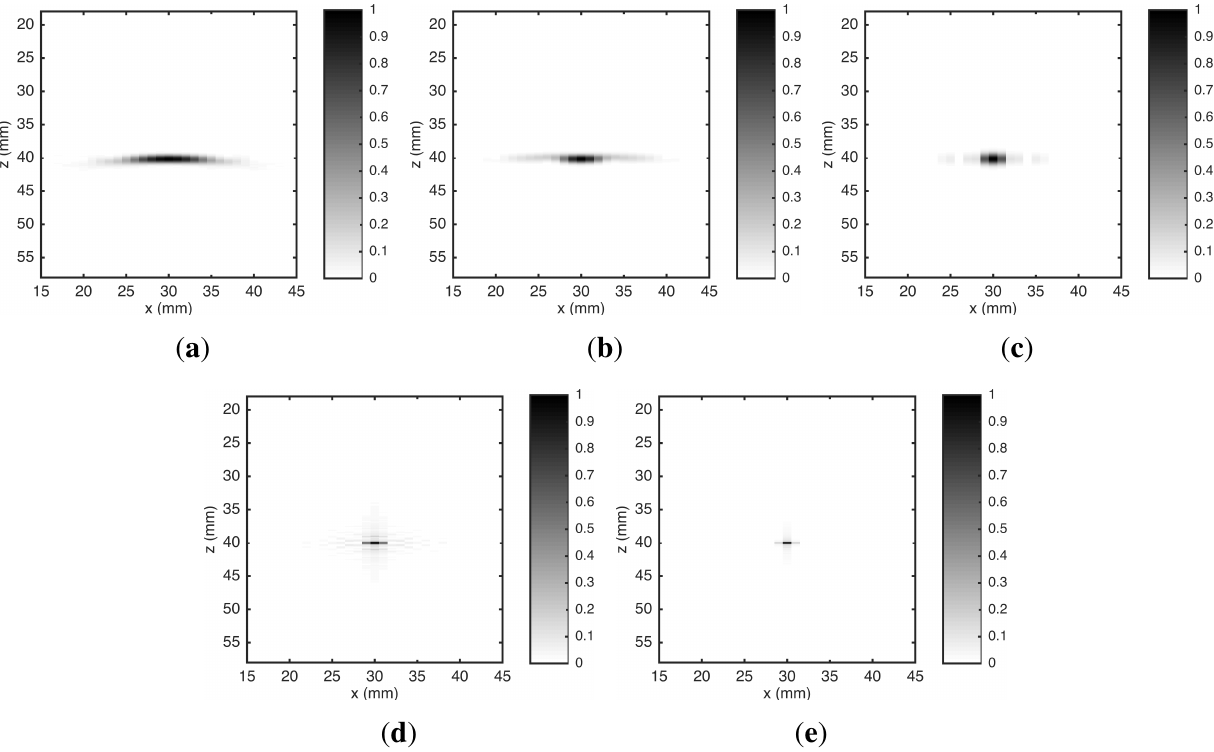
Figure 3. Reconstructed images of a point-like reflector from simulated data. The algorithms used in the reconstruction are: ( a ) B-scan ; ( b ) SAFT; ( c ) ω - k SAFT; ( d ) RLS and ( e ) UTSR. Amplitude scale is normalized to maximum absolute